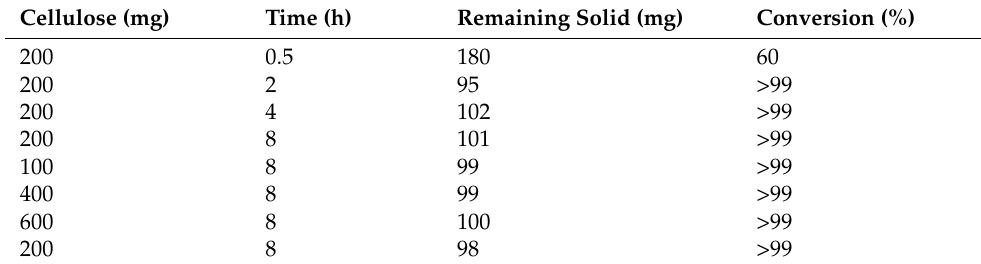
Table 1. Effects of reaction time and substrate loading on cellulose